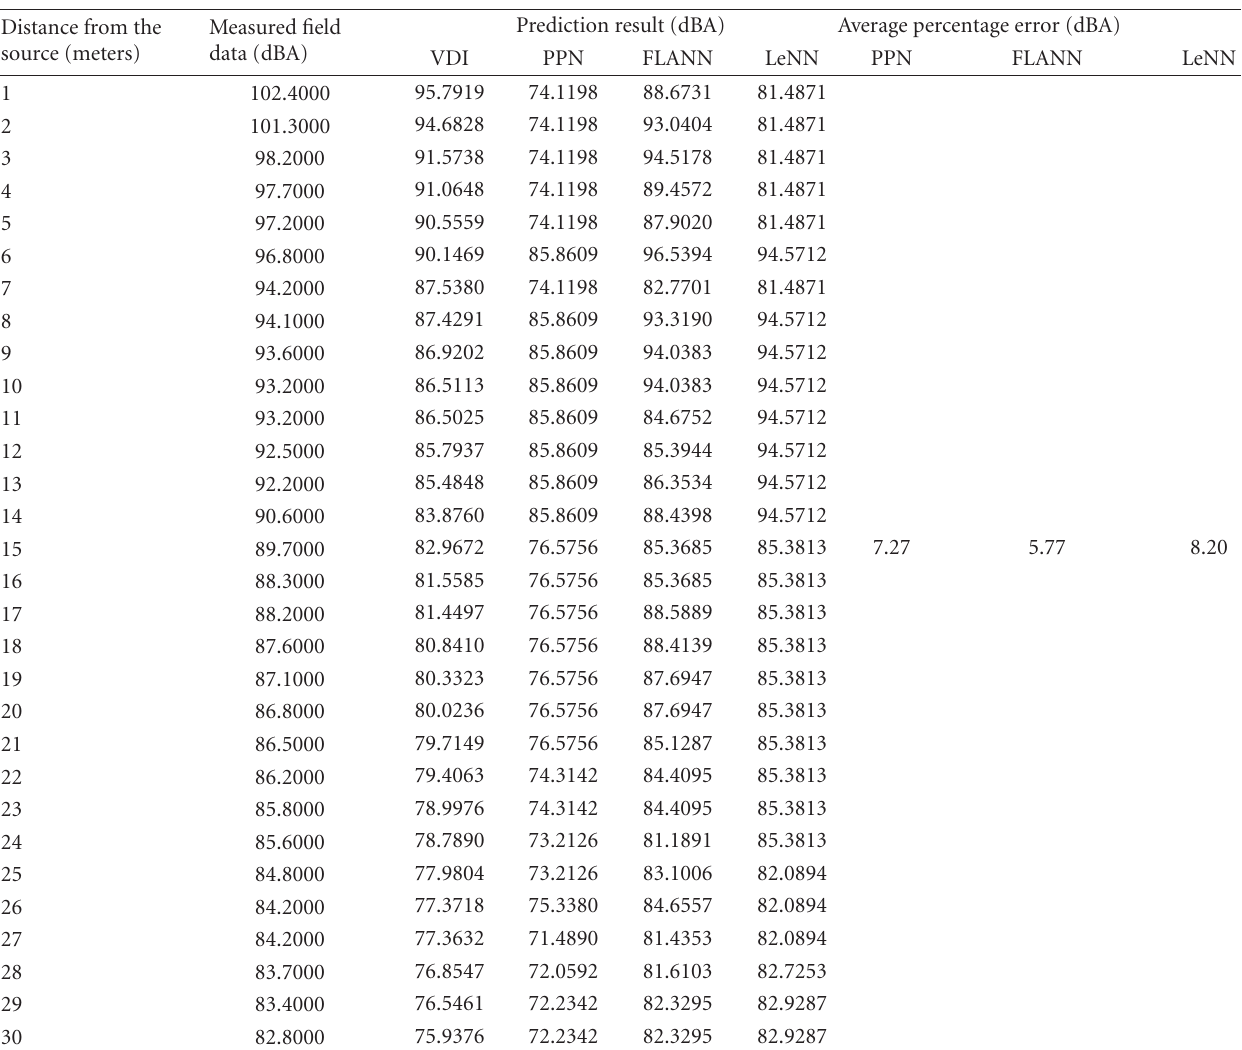
Table 2: Simulation study of dumper